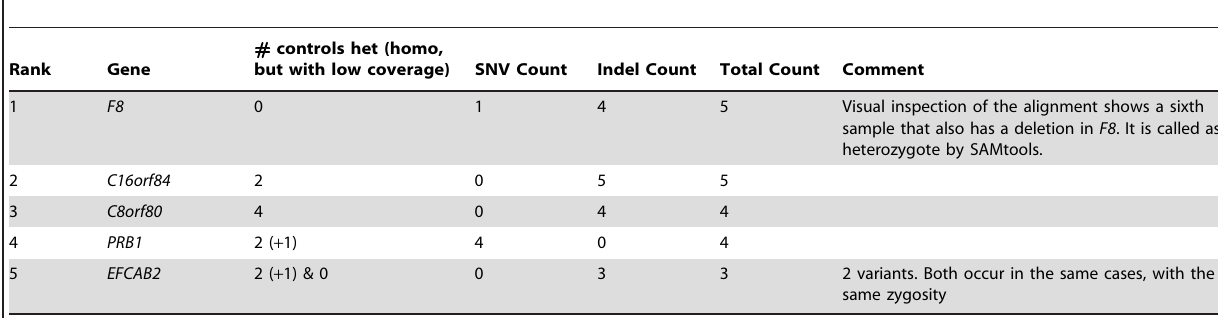
Table 2. Prioritization of protein-truncating or stop loss variants enriched in hemophilia samples.